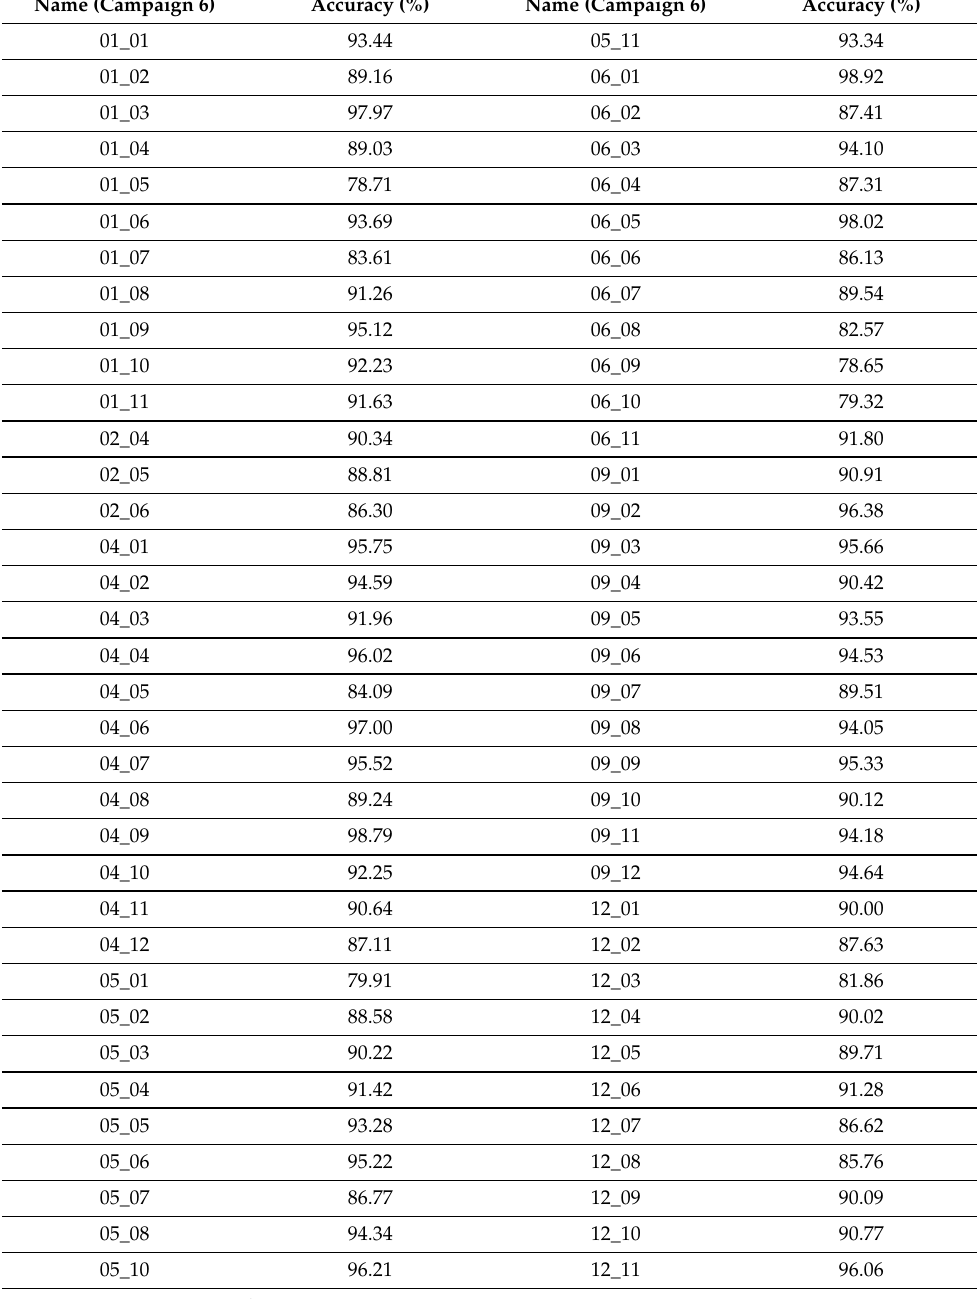
Table 5. Accuracy obtained on 70 specimens by classifying their stems and leaves